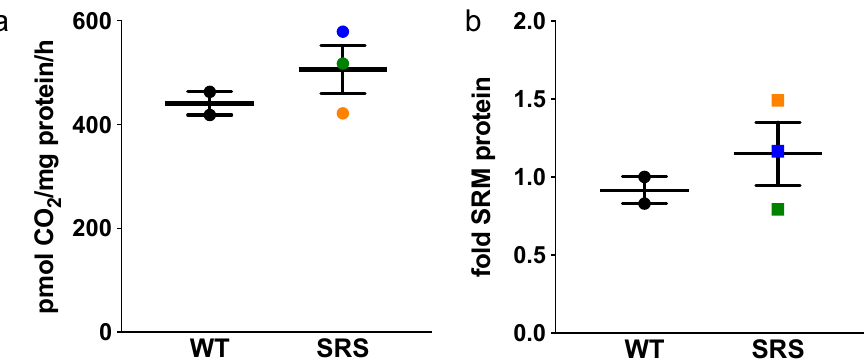
Figure 4. ( a ) Basal AdoMetDC activity ( n = 2, in triplicate) of donor or SRS lymphoblast lines. Color designations are orange (SRS1), blue (SRS2), and green (SRS3). ( b ) Quantitative Western blots of SRM in lymphoblast cell lines ( n = 2). All error bars indicate SEM.